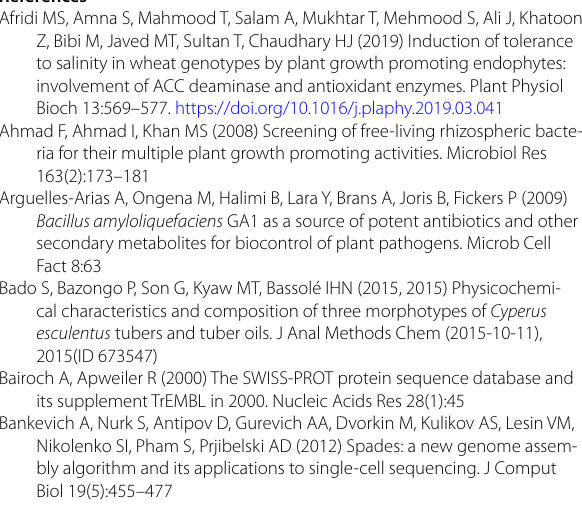
Additional file 2: Tables S2. CAZy annotation. Table S3. VFDB. Table S4. PHI. Table S5. Secretion System. Table S6. CARD. Table S7. Two